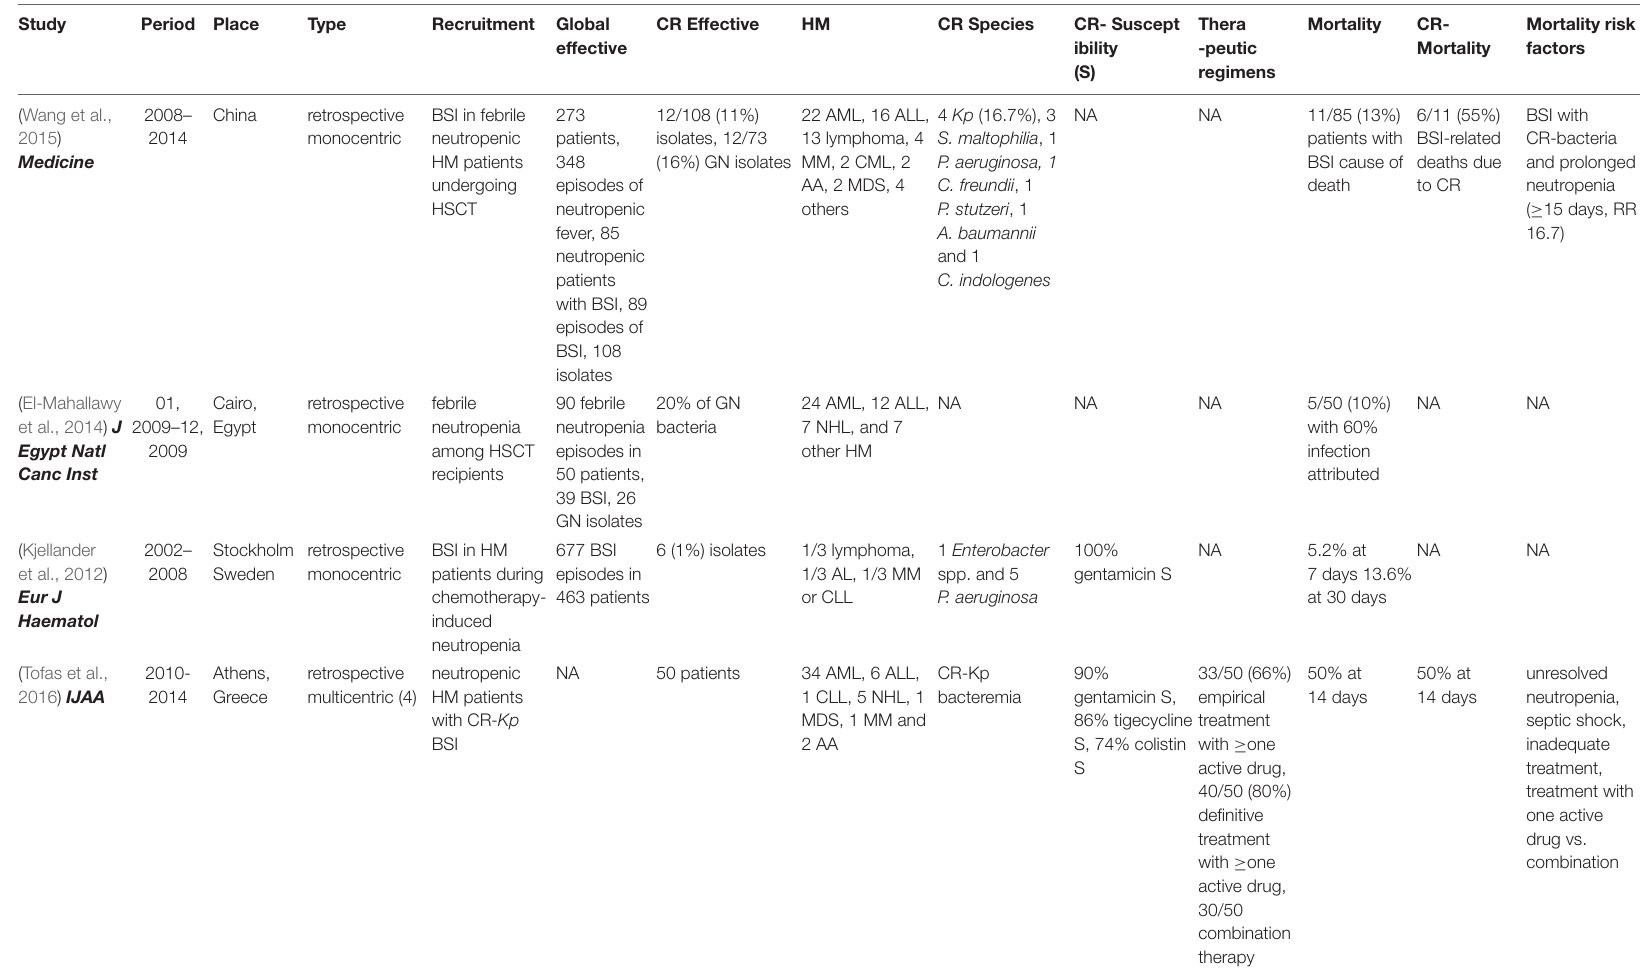
TABLE 3 | Characteristics of the studies reporting CR bacteria in HM neutropenic patients.